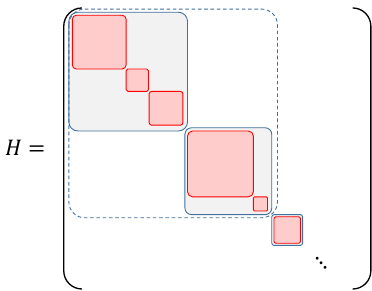
Figure 3: Structure of the block-diagonalized Hamiltonian. Dashed blocks corre- spond to M values. Solid blue blocks correspond to symmetry sectors characterized by M ≡ ( M , M x , M y ) quantum numbers. Solid red blocks correspond to fragments. The red block structure is a property of the Hamiltonian alone, while the other blocks are imposed by the